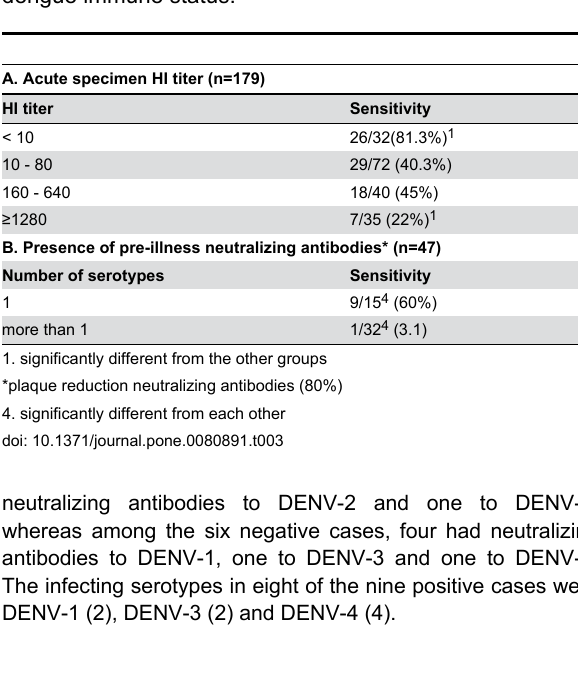
Table 3. Sensitivity of the NS1 antigen test according to dengue immune status.